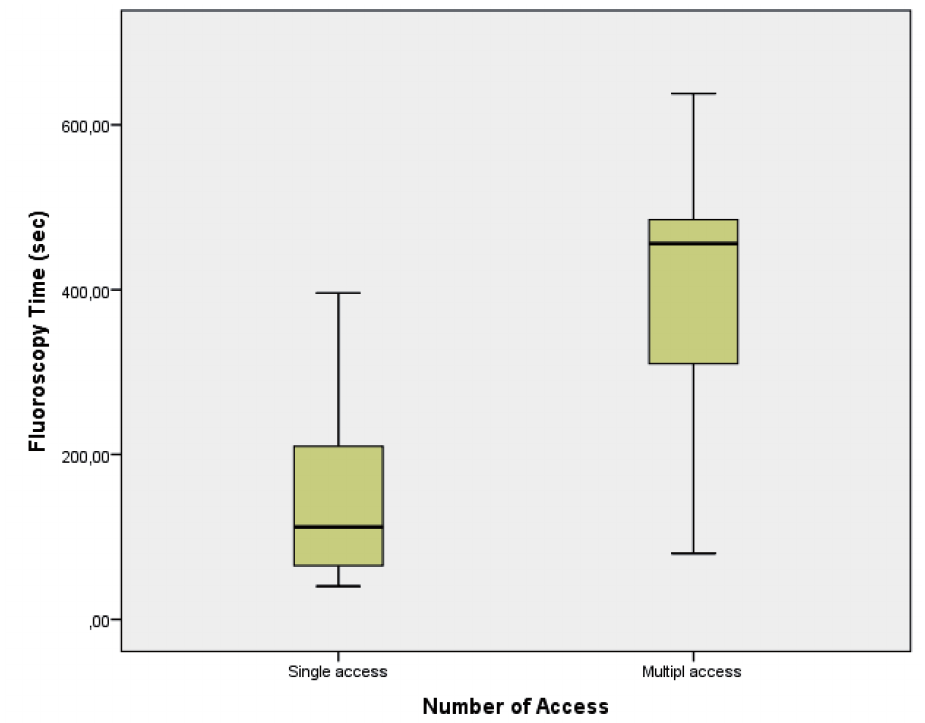
Figure 3 - Effect of multi access on Fluoroscopy